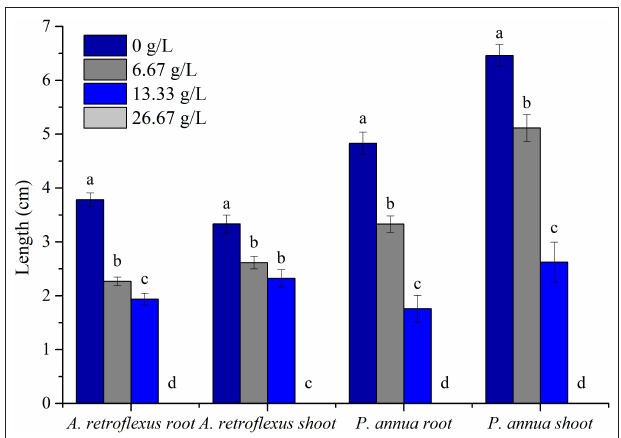
FIGURE 1 | Allelopathic effect of volatile organic compounds (VOCs) released by Thymus proximus on the root and shoot elongation of Amaranthus retroflexus and Poa annua . Means with different letters indicate significant differences at p < 0.05 level according to the Fisher’s least significant difference (LSD)